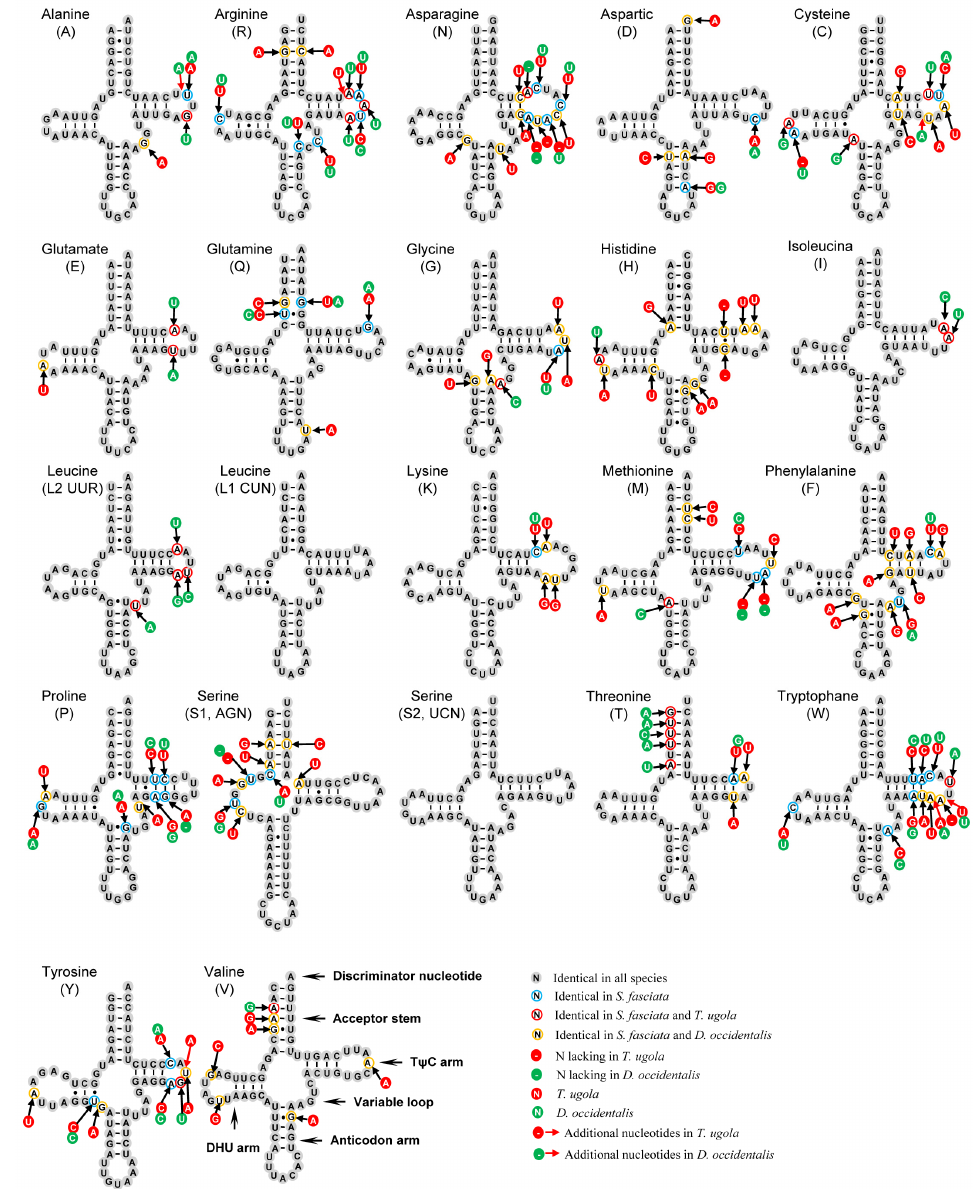
Figure 4. Predicted secondary structures of 22 tRNAs in S. fasciata . Conserved sites within three taeniopterygid species are indicated as black nucleotides within gray spheres. Red arrows correspond to insertions.